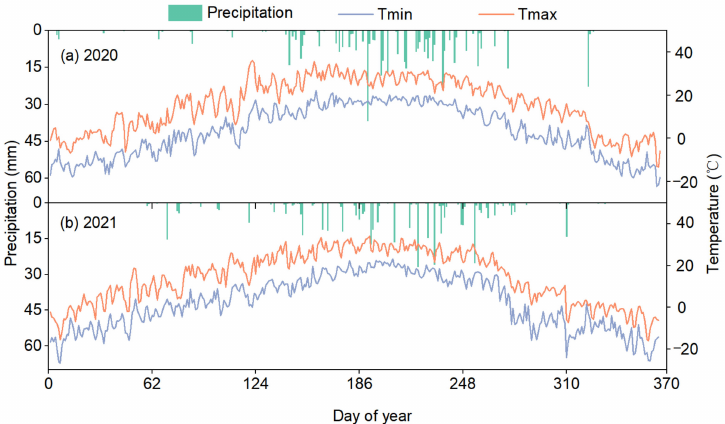
Figure 1. Precipitation, maximum (Tmax) and minimum (Tmin) air temperature in the experimental field (2020 and 2021, the datasets were from the HOBOU-30 meteorological station).